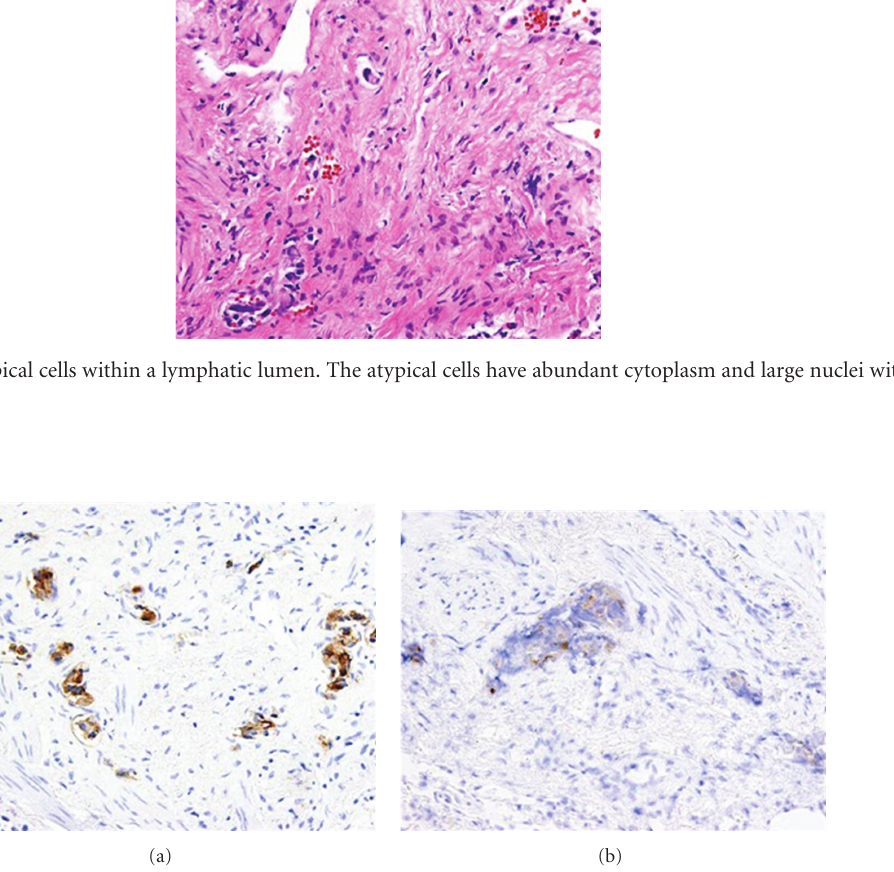
Figure 3: Prostate-specific antigen (PSA) and prostate-specific acid phosphatase (PSAP) stains, 40x. Metastatic prostate adenocarcinoma within lymphatic spaces, as demonstrated by PSA and PSAP